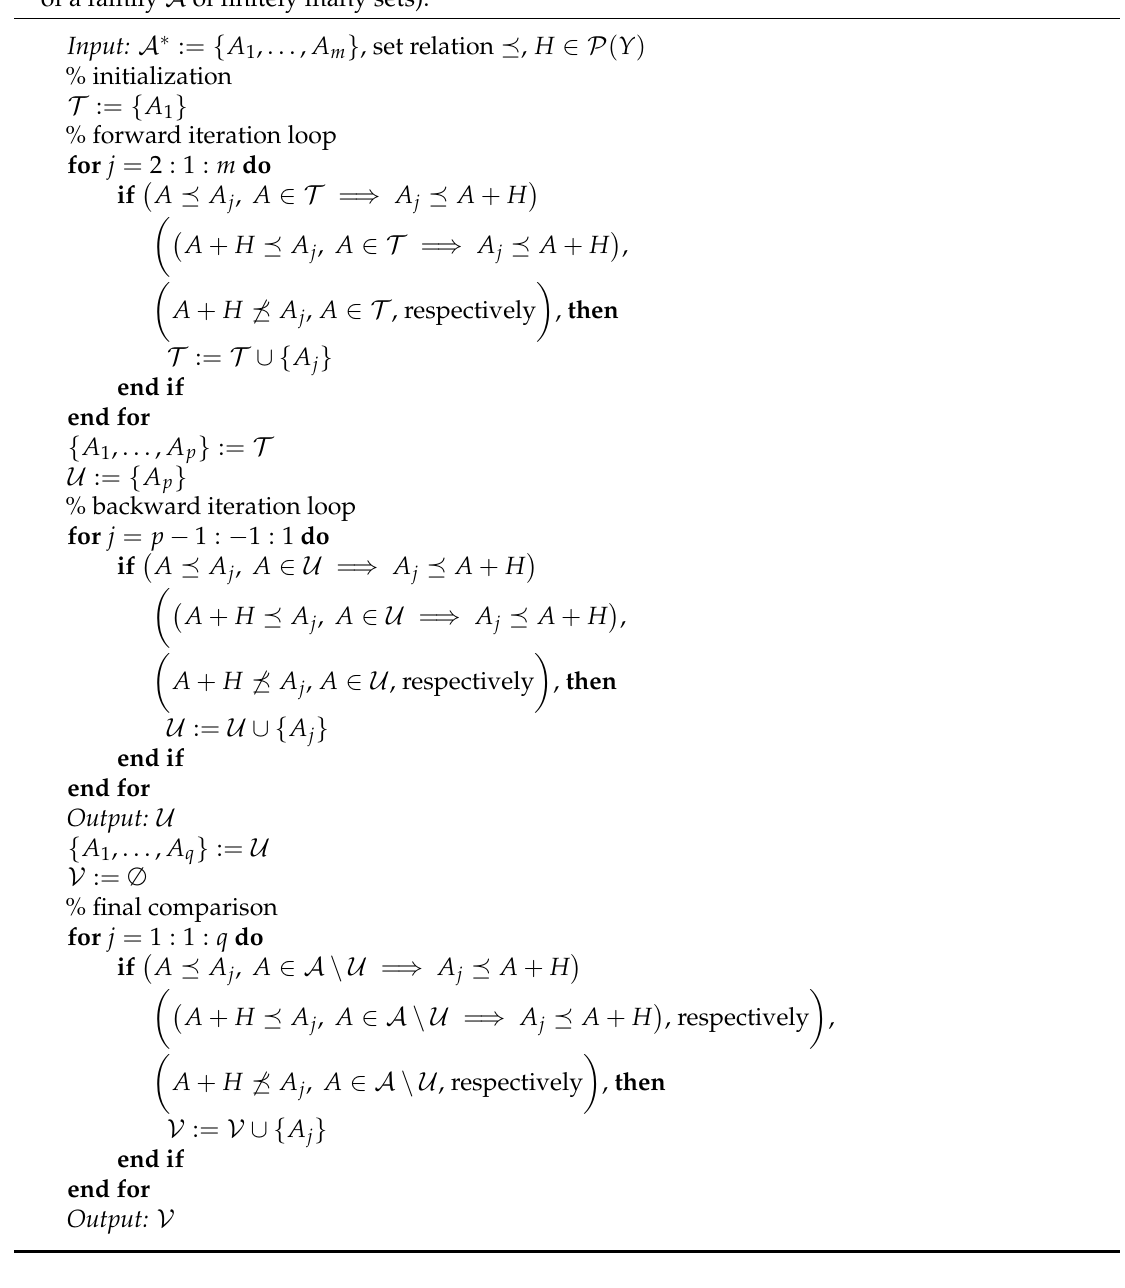
Algorithm 2: (Method for finding H 1 - ( H 2 -, H 3 -, respectively) approximate minimal elements of a family A of finitely many